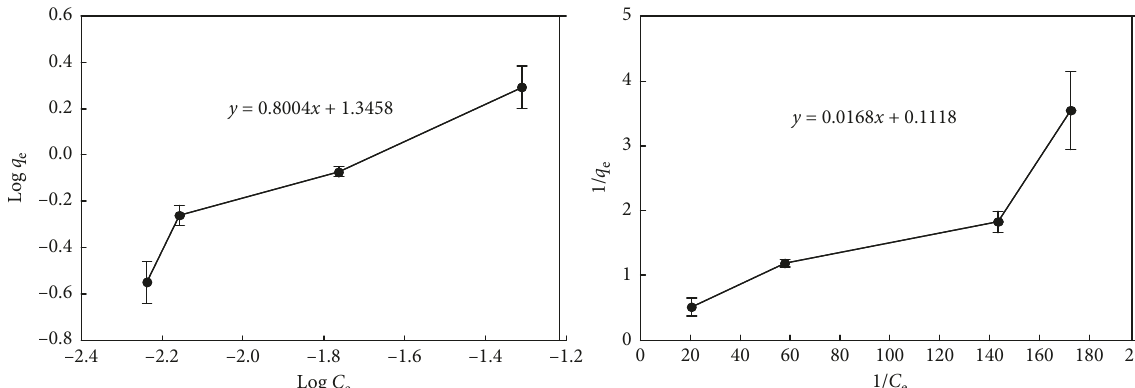
Figure 2: Arsenic adsorption efficiencies of commercial titanium powders (initial As concentration: 0.2 mg/L; quantity of adsorbents: 0.01g). Table 1: Freundlich and Langmuir isotherm analysis of TiO Constants of Freundlich and Langmuir isotherm